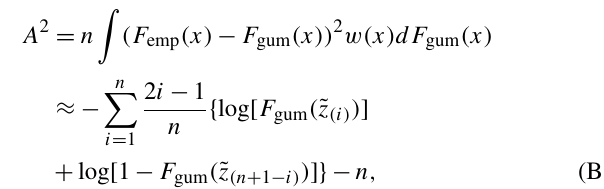
. (c) Beaufortain massif at 2700m fitted with the model M ζ 0 ,µ 1